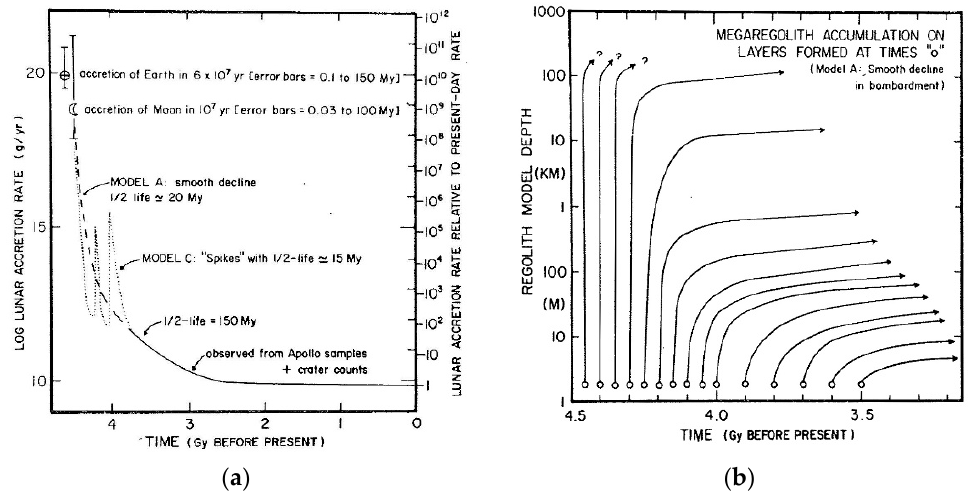
Figure 16. ( a ) The 1980 models of declining impact rate since planetary formation used to estimate megaregolith growth in different eras. “Model A” assumes constantly declining flux with assumed rate of increase of half-life for surviving planetesimals. “Model C” allows impact spikes around 4.0 Ga ago. These models contrast with then-prevailing assumption of low impact rate between ~4.4 and 3.9 Ga ago. ( b ) The 1980 model of regolith depth as a function of time, generated on surfaces formed at any given time (horizontal axis). The model assumes the smoothly declining impact rate shown as “Model A” in figure ( a ). This model is based on depths of craters of diameter D, such that the total area of covered by craters of size >D is 100–200% of the area of the Moon (see Figure 15). Under the assumed conditions, regolith would be ~1 km deep on surfaces formed at 4.2 Ga ago, but only about 30 m deep on surfaces formed at 3.9 Ga ago.